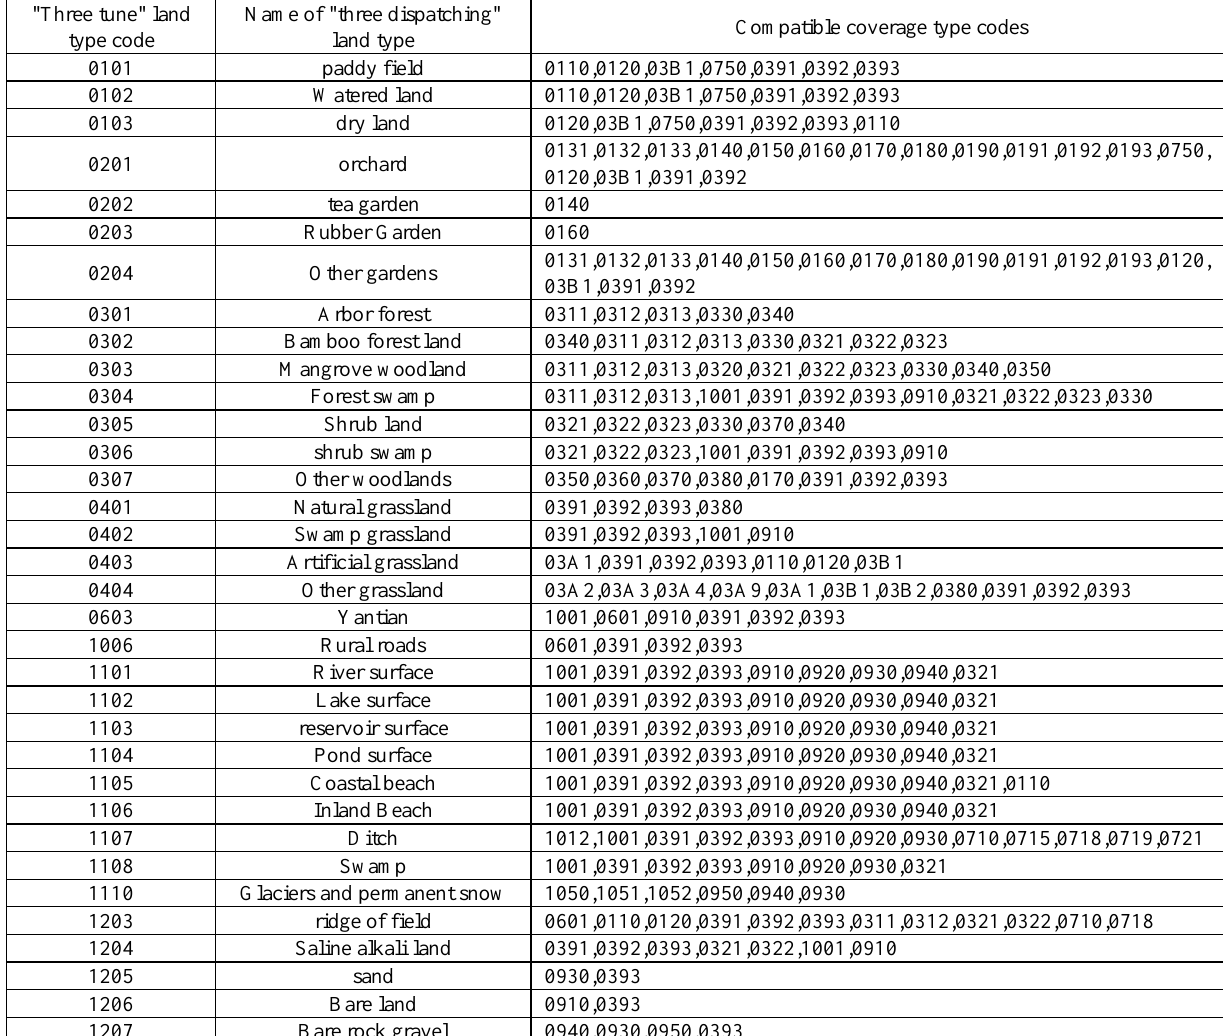
Table 2. Comparison between surface coverage data types and the compatibility of "three regulation" land